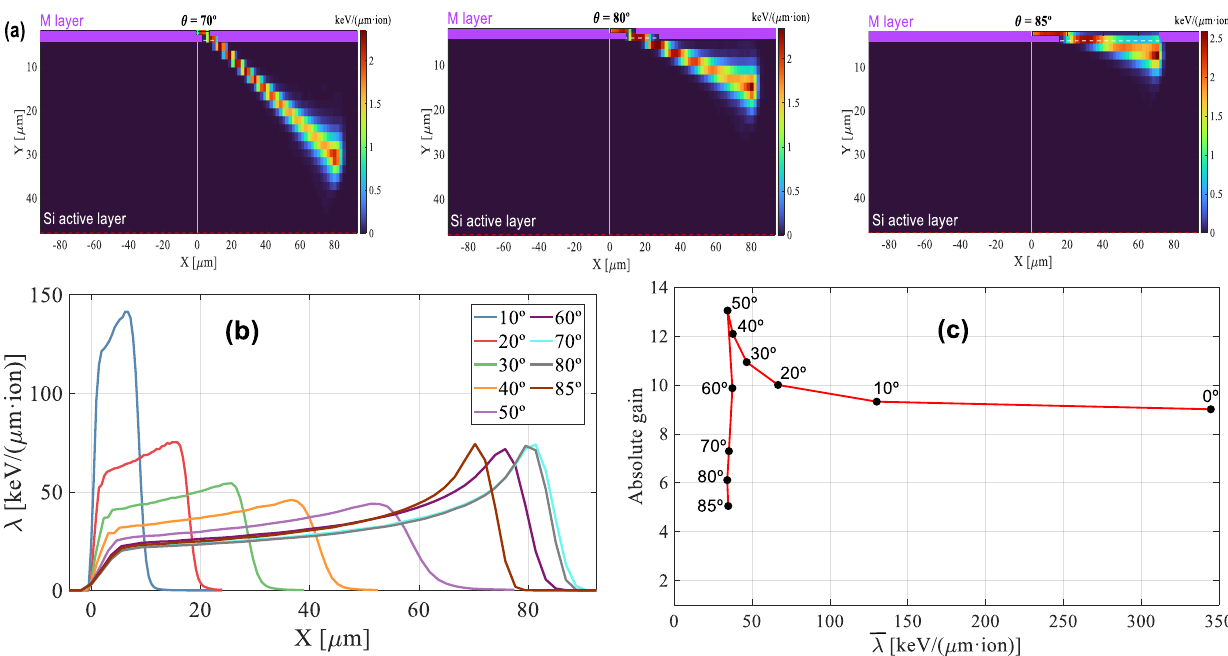
Figure 18. ( a ) SRIM simulations at 70 ◦ , 80 ◦ and 85 ◦ . Purple area is the multiplication layer. ( b ): Ion- ization density projected on the gain layer curves up to 85 ◦ . ( c ): absolute gain versus mean linear ionisation density at 130 V.